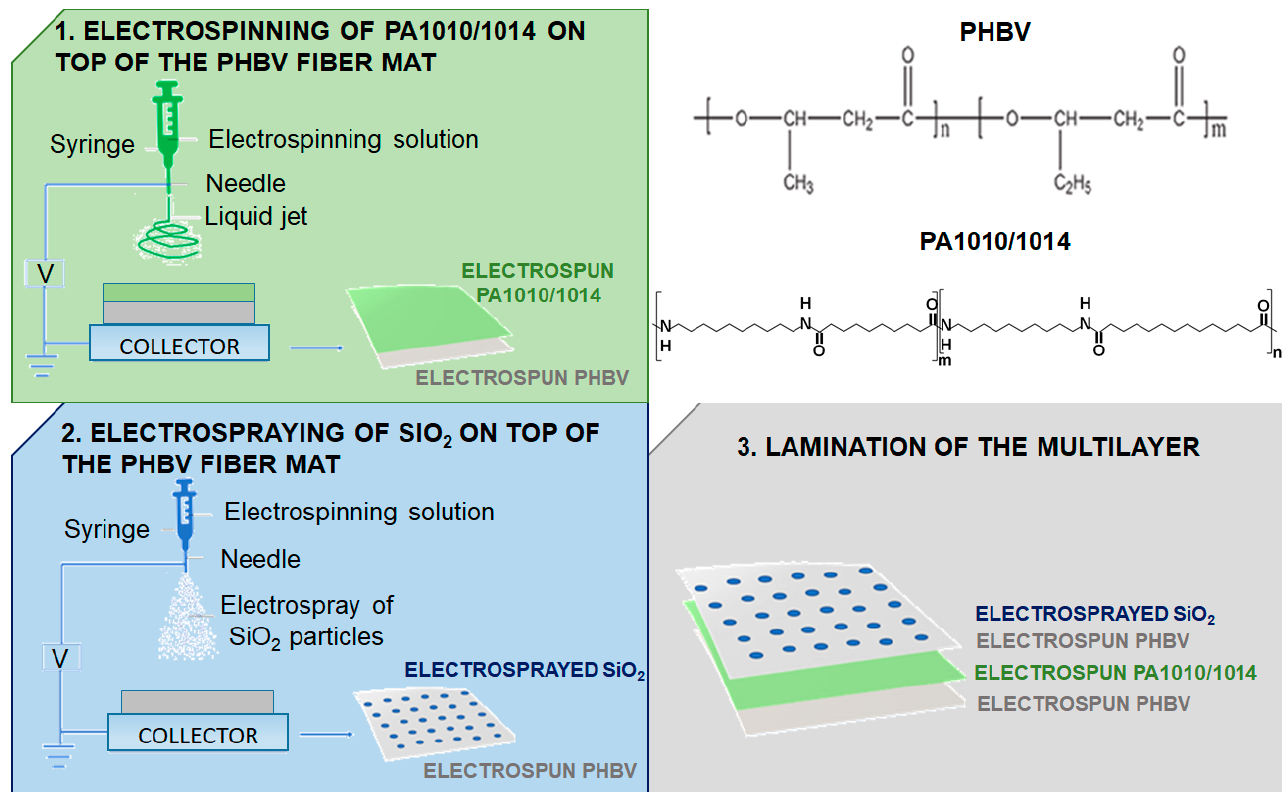
Figure 1. Scheme of the electrospun multilayered film production process and chemical structure of the biopolymers used.